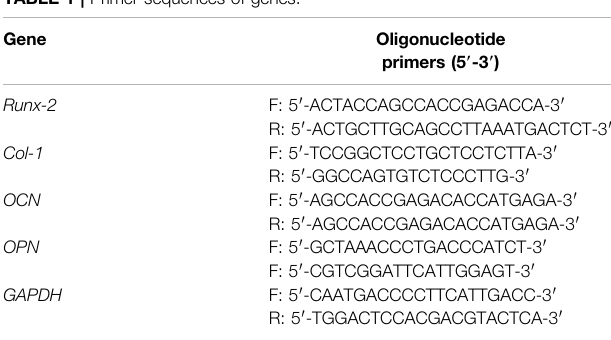
TABLE 1 | Primer sequences of